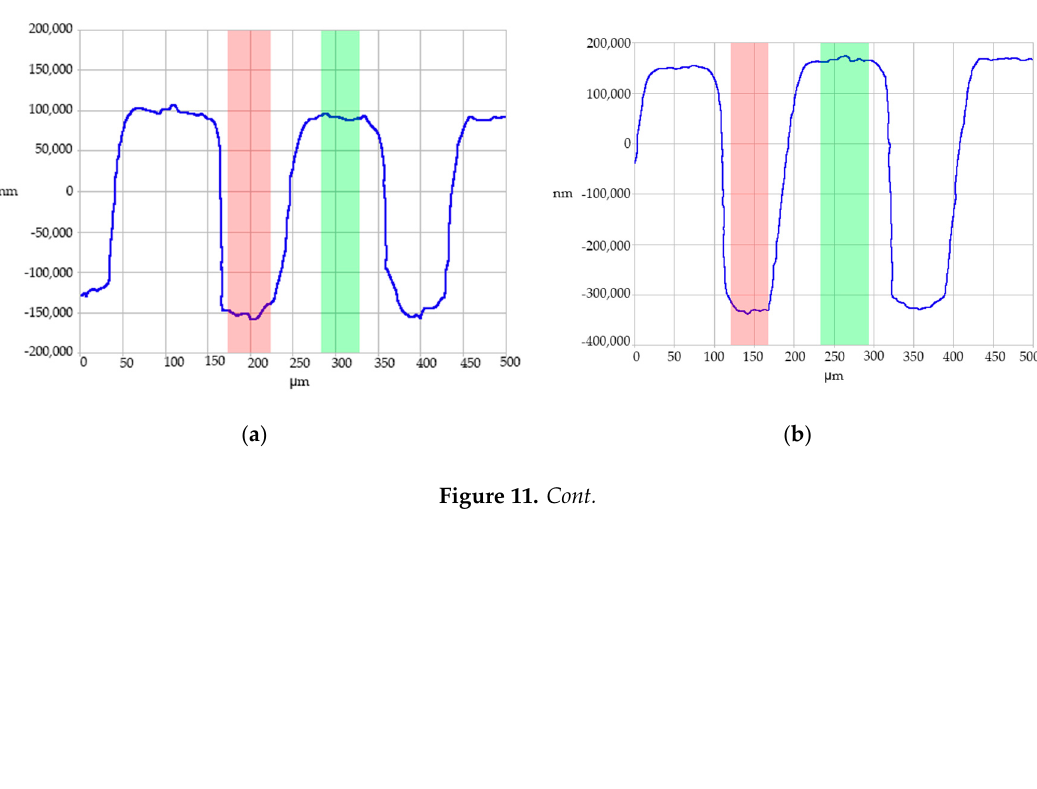
Figure 10. SEM images of Tool 5 ′ s Group D channels exhibiting ( a ) brittle failure and ( b ) thermal- induced surface